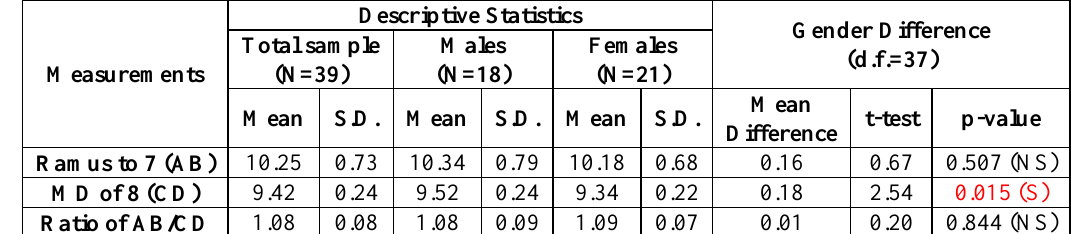
Table 2 : Descriptive statistics and gender difference for the variables measured in 2D image